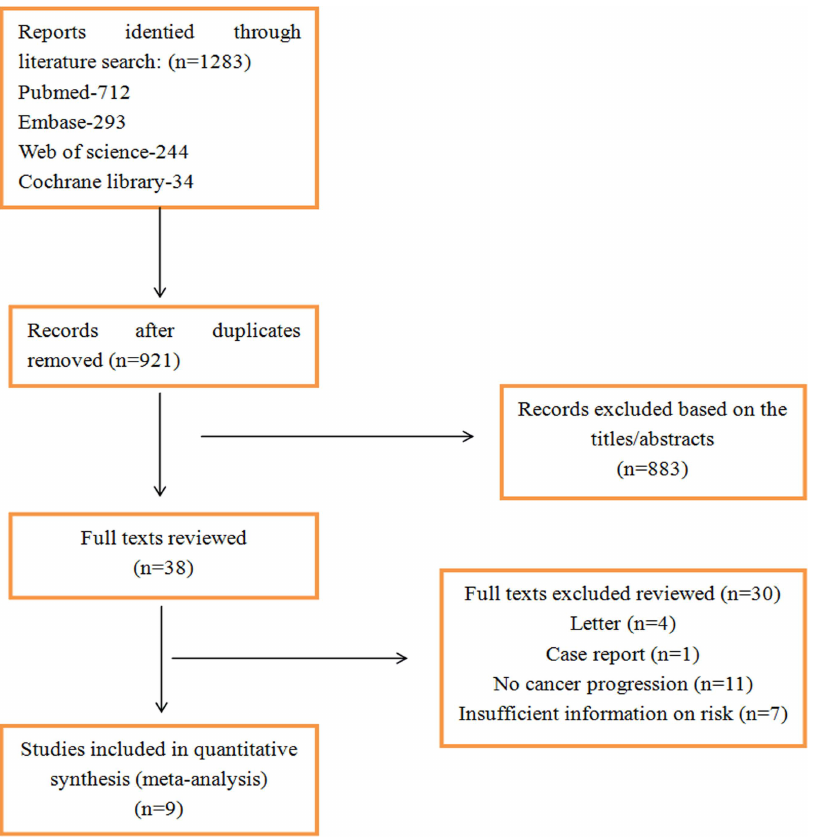
Fig 1. Flow diagram showing results of search and reasons for exclusion of